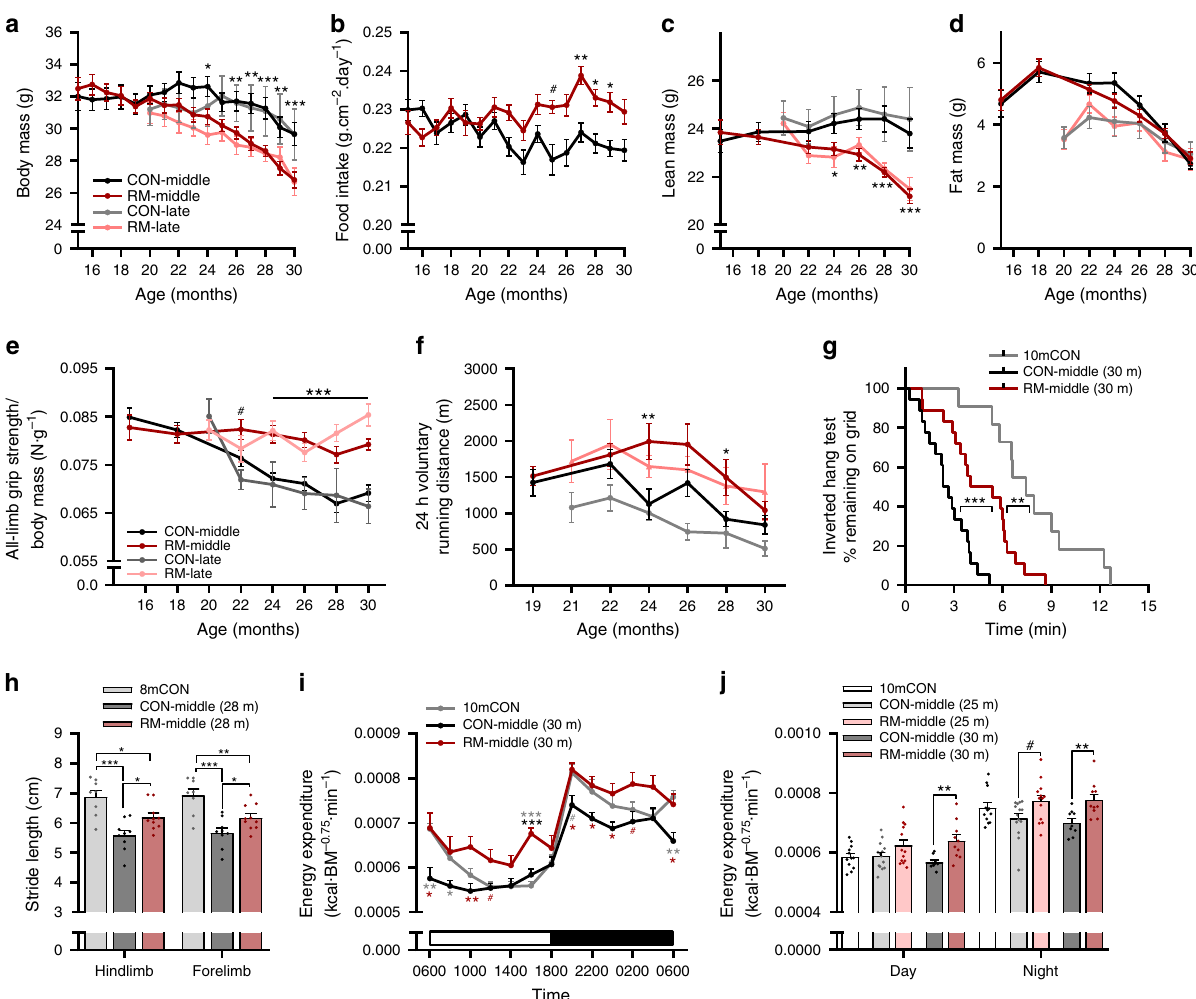
Fig. 1 Rapamycin slows age-related decrements in whole-body muscle function and metabolism. a Body mass for mouse groups receiving rapamycin (~4 mg kg − 1 day − 1 ) or control diet beginning at 15 months (CON-middle and RM-middle) or 20 months (CON-late and RM-late) of age; n = 18 (CON-middle), 17 (RM-middle), 5 (CON-late), and 9 (RM-late) mice. b Mean daily food intake for middle-aged groups; n = 18 (CON-middle) and 17 (RM-middle) mice. Bimonthly recordings of whole-body lean ( c ) and fat mass ( d ); n = 18 (CON-middle), 17 (RM-middle), 6 (CON-late), and 9 (RM-late) mice. e All-limb grip strength normalized to body mass; n = 19 (CON-middle), 18 (RM-middle), 6 (CON-late), and 9 (RM-late) mice. f Twenty-four hours of voluntary running- wheel distance; n = 16 (CON-middle), 15 (RM-middle), 6 (CON-late), and 9 (RM-late) mice. Note that improvements by rapamycin were similar, irrespective of the time of treatment onset. g Kaplan – Meier plot for the inverted grip-hang test performed prior to endpoint measures at 30 months of age for the middle-aged group; n = 11 (10mCON), 18 (CON-middle), and 18 (RM-middle) mice. h Gait analysis of forelimb- and hindlimb-stride length at 28 months of age for middle-aged groups; n = 8 (8mCON), 9 (CON-middle), and 10 (RM-middle) mice. i Whole-body metabolic analysis of energy expenditure normalized to body surface area reported every 2 h across one full day (white)/night (black) cycle in the month prior to endpoint measures and j mean day and night values recorded at 25 and 30 months of age for middle-aged groups; n = 12 (10mCON), 14 (25mCON), 13 (25mRM), 9 (30mCON), and 10 (30mRM) mice. Data are presented as mean ± SEM. For a , b , e , and f , both control groups (CON-late and CON-middle) and both RM groups (RM-late and RM-middle) were combined for statistical comparisons. Two-way repeated-measure ANOVA with Sidak or Tukey post hoc tests ( a – f , i – j ), Mantel – Cox log rank ( g ), and one-way ANOVA with Fisher ’ s LSD post hoc tests ( h ) was used to compare the data. *, **, and *** denote a signi fi cant difference between groups of P < 0.05, P < 0.01, and P < 0.001, respectively. # denotes a trend where 0.05 < P < 0.10. Colored asterisks refer to the group of comparison. compared to 10-month-old control mice (10mCON) when muscle-speci fi c responses to rapamycin were also evident in normalized to body mass (Fig. 2a) and for absolute mass absolute muscle mass, where triceps was signi fi cantly heavier and (Supplementary Fig. S2A). Despite the ubiquitous age-related GAS signi fi cantly lighter in 30mRM than 30mCON mice reductions in limb muscle mass, the effects of rapamycin were (Supplementary Fig. S2A). Long-term rapamycin treatment also muscle-speci fi c. Rapamycin protected against the age-related loss prevented the age-related increase in heart mass, and attenuated of relative muscle mass in the tibialis anterior (TA), extensor the increase in mass of nonfunctional tissues, such as the seminal digitorum longus (EDL), and triceps brachii (TRI) muscles, vesicles, but induced severe testicular degeneration (Supplemen- partially protected relative mass in the quadriceps (QUAD), tary Fig. S2B), as previously observed 7 . Scatterplots showed a strong linear relationship between muscle and body mass in all plantaris (PLA), and soleus (SOL) muscles, but did not protect groups. However, for the same body mass, muscle mass was lower relative mass in the gastrocnemius (GAS) muscle (Fig. 2a). The NATURE COMMUNICATIONS| (2020) 11:4510